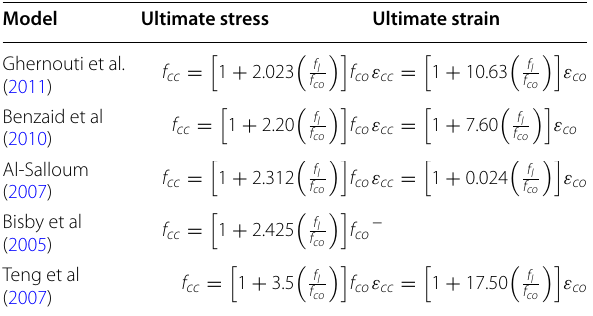
Table 6 Ultimate strength models.